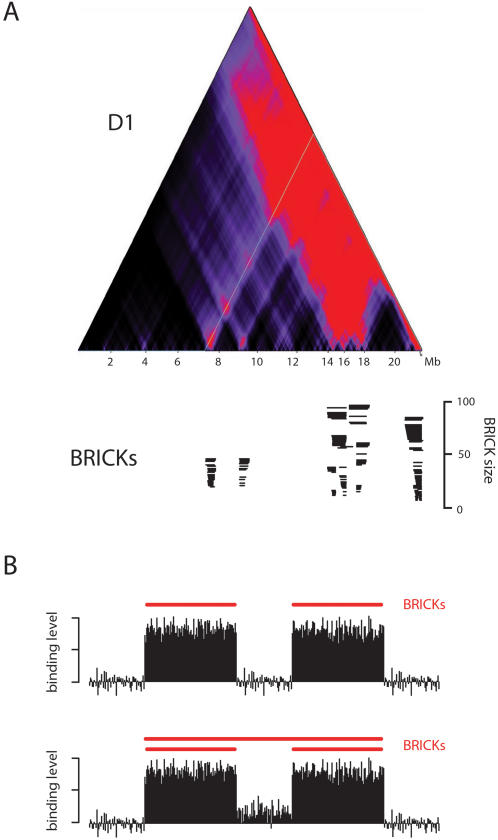
Identification of the most probable locations of discrete chromatin domains.An algorithm based on dynamic programming (see Methods) was used to identify the most probable partitioning into discrete domains of local enrichment (BRICKs). A) Top panel: domainogram of D1 on chromosome arm 2L. Bottom panel: corresponding locations of identified BRICKs (up to a BRICK size of 100). Nested BRICK structures can be identified, in which large BRICKs overlap with smaller BRICKs. They are visualized as a stack of BRICKs, and are all used for subsequent functional analyses. B) Simplified cartoon illustrating that the BRICK detection algorithm only combines two smaller BRICKs into one larger BRICK if the protein binding values between the two smaller BRICKs are significantly elevated above background. Thus, higher-level BRICKs are not just a trivial consequence of two smaller BRICKS being in close proximity of one another.